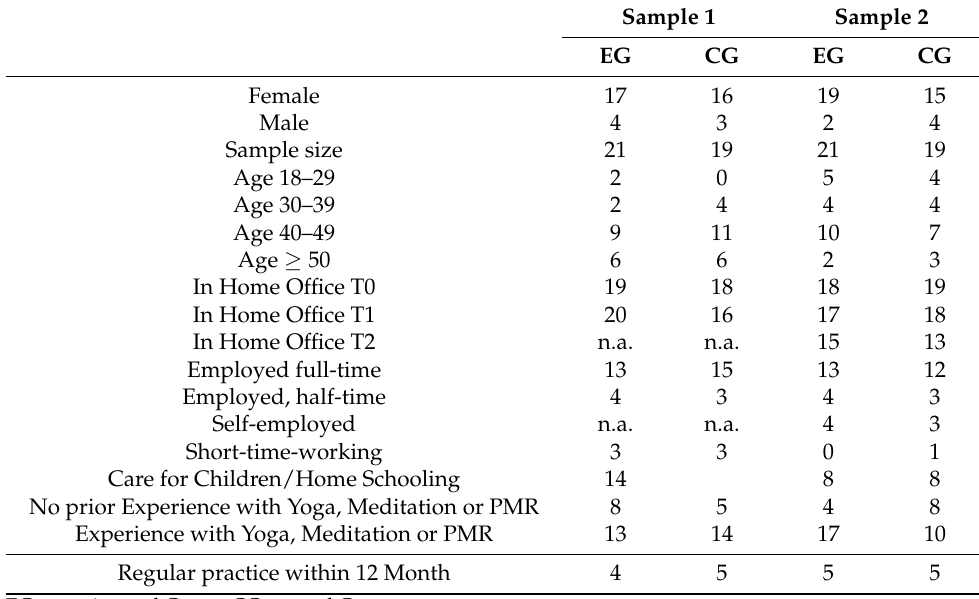
Table 2. Sample Survey 1 and